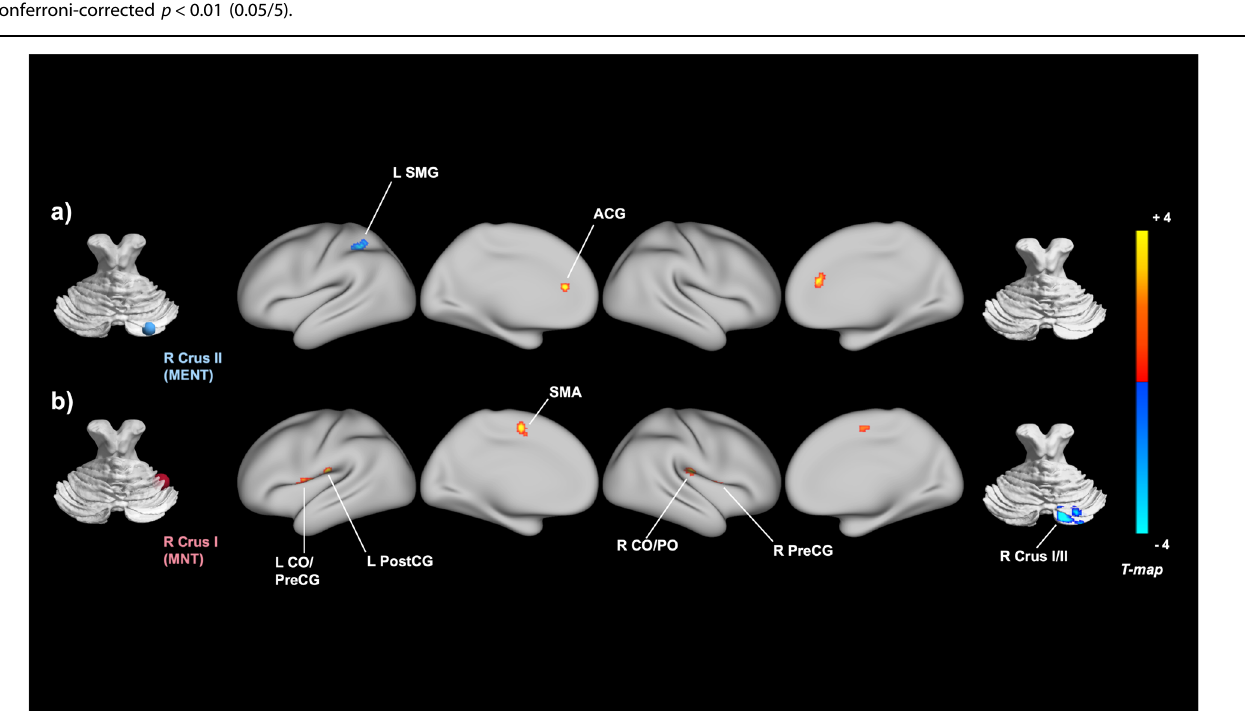
Fig. 1 Brain regions showing between-group connectivity differences with social cerebellar regions of interest (ROIs) from seed-to-voxel analysis. Signi fi cant clusters of the between-group analyses obtained for the two cerebellar ROIs are presented in a combined view: a right crus II, which is functionally connected to the mentalizing network (MENT), and ( b ) right crus I, which is functionally connected to the mirror neuron system (MNS). Blue and red clusters indicate signi fi cant hypoconnectivity and hyperconnectivity with the cerebellar seeds, respectively. R right, L left, SMG supramarginal gyrus, ACG anterior cingulate gyrus, CO central operculum, PreCG precentral gyrus, PostCG postcentral gyrus, SMA supplementary motor area, PO parietal operculum; R Crus II (MNI coordinates + 26, − 84, − 32); and R Crus I ( + 40, − 48, − 32). Statistical signi fi cance of the cluster threshold was set at false discovery rate (FDR)-corrected p < 0.05. The color bar indicates T